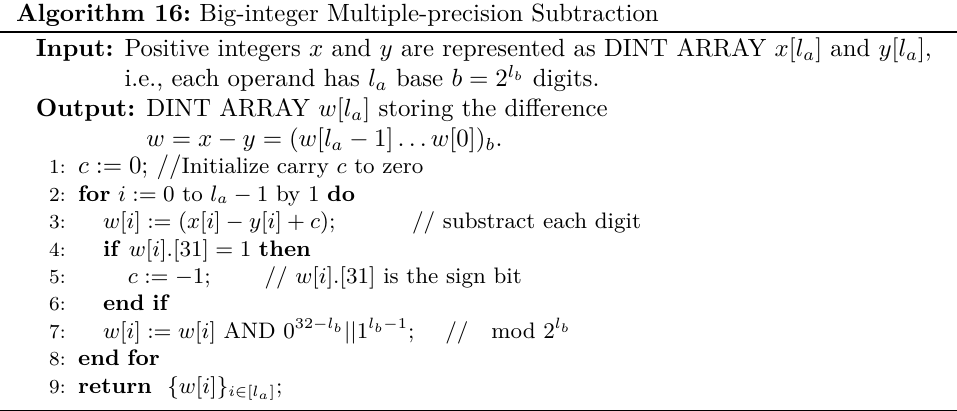
Algorithm 16: Big-integer Multiple-precision